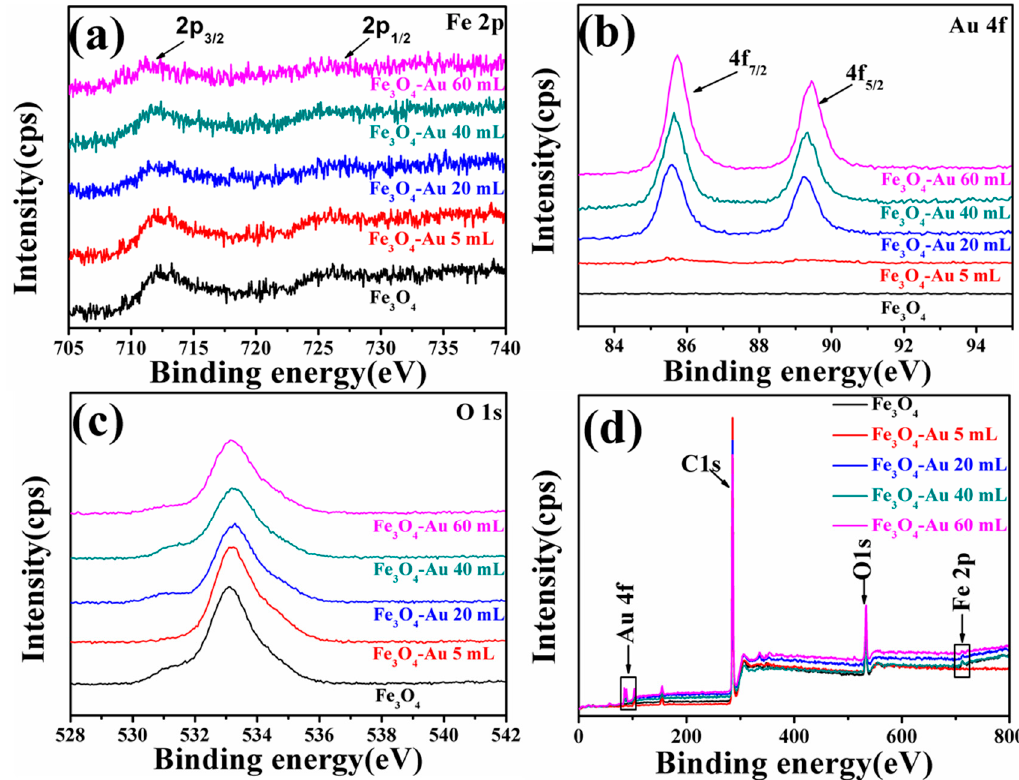
Figure 6. XPS spectra of the as-obtained Fe 3 O 4 , Fe 3 O 4 -Au 5 mL, Fe 3 O 4 -Au 20 mL, Fe 3 O 4 -Au 40 mL and Fe 3 O 4 -Au 60 mL: the Fe 2p binding energies ( a ), the Au 4f binding energies ( b ), the O1s binding energies ( c ) and XPS survey spectra ( d